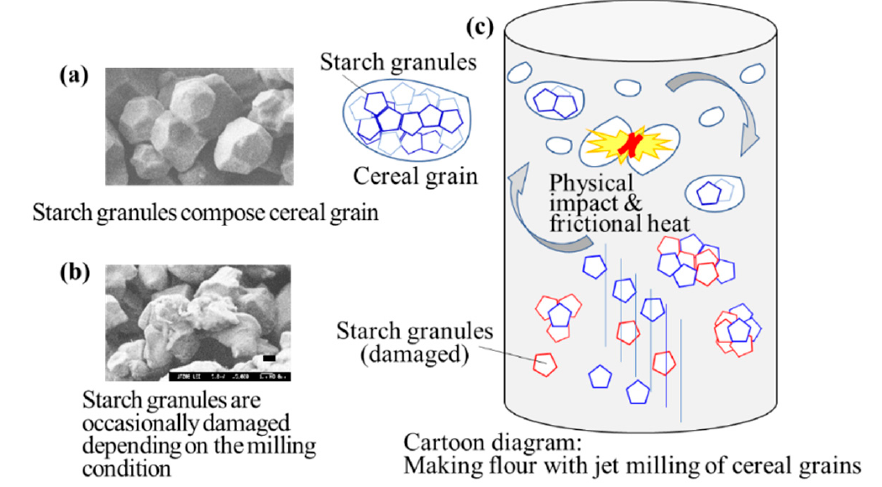
Figure 2. Comparison of starch granules with low ( a ) and high ( b ) starch damage. Drawing of the jet milling process ( c ).